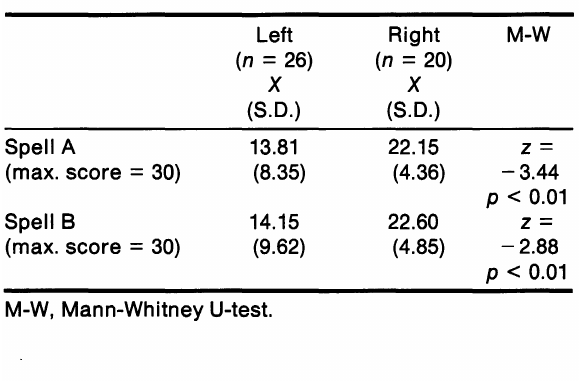
TABLE V. Differences between the right and left lesion groups on the GDST (Forms A and B)